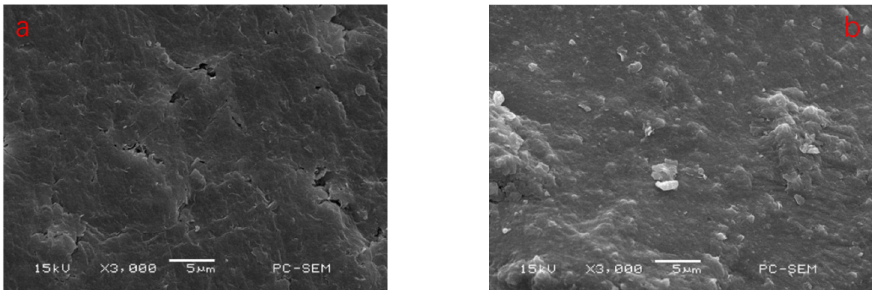
Figure 10. SEM images of montmorillonite before and after welan gum adsorption. ( a ) Before ad- sorption; ( b ) After adsorption